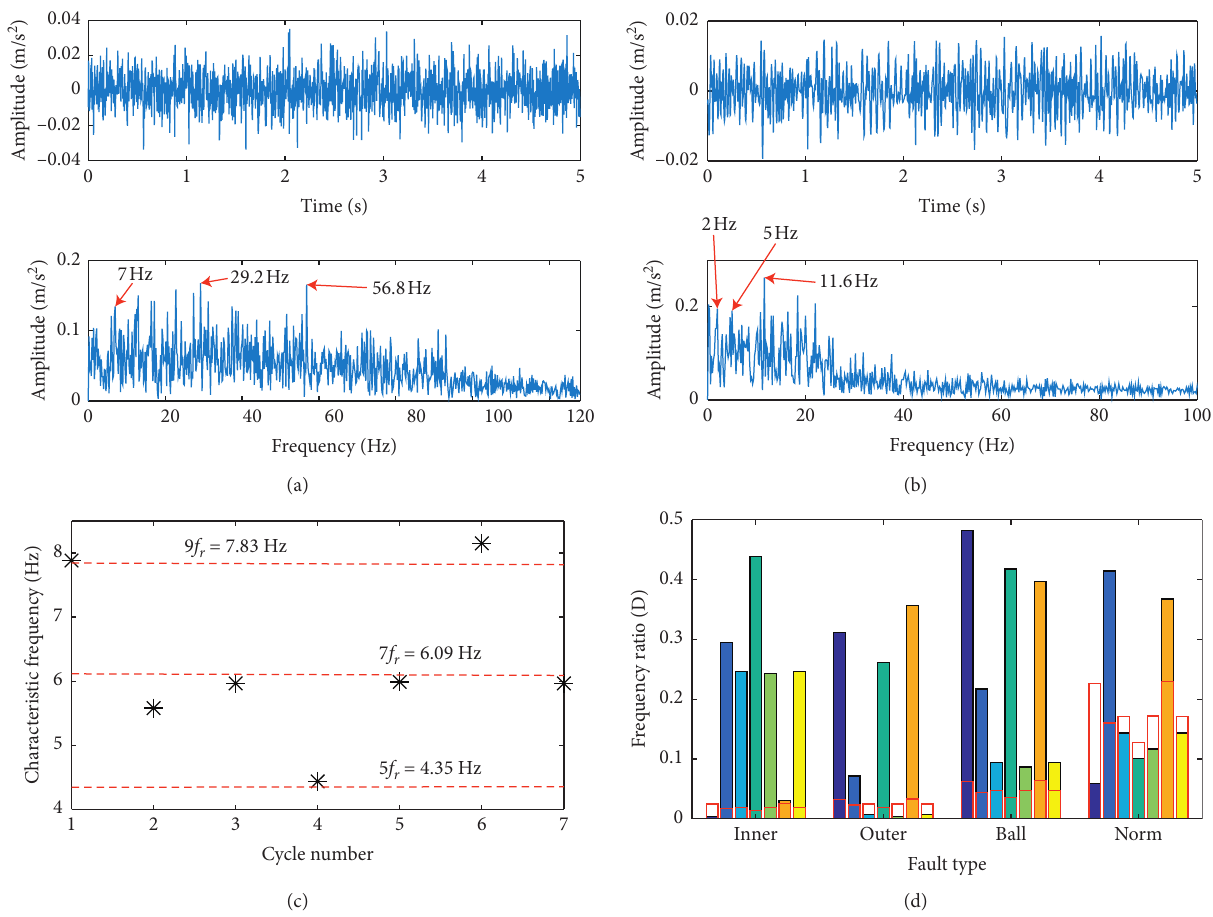
Figure 20: The diagnosis process of field vibration data: (a) the original signal; (b) the reconstructed signal; (c) characteristic frequency in each cycle; (d) the frequency ratio of fault types in each